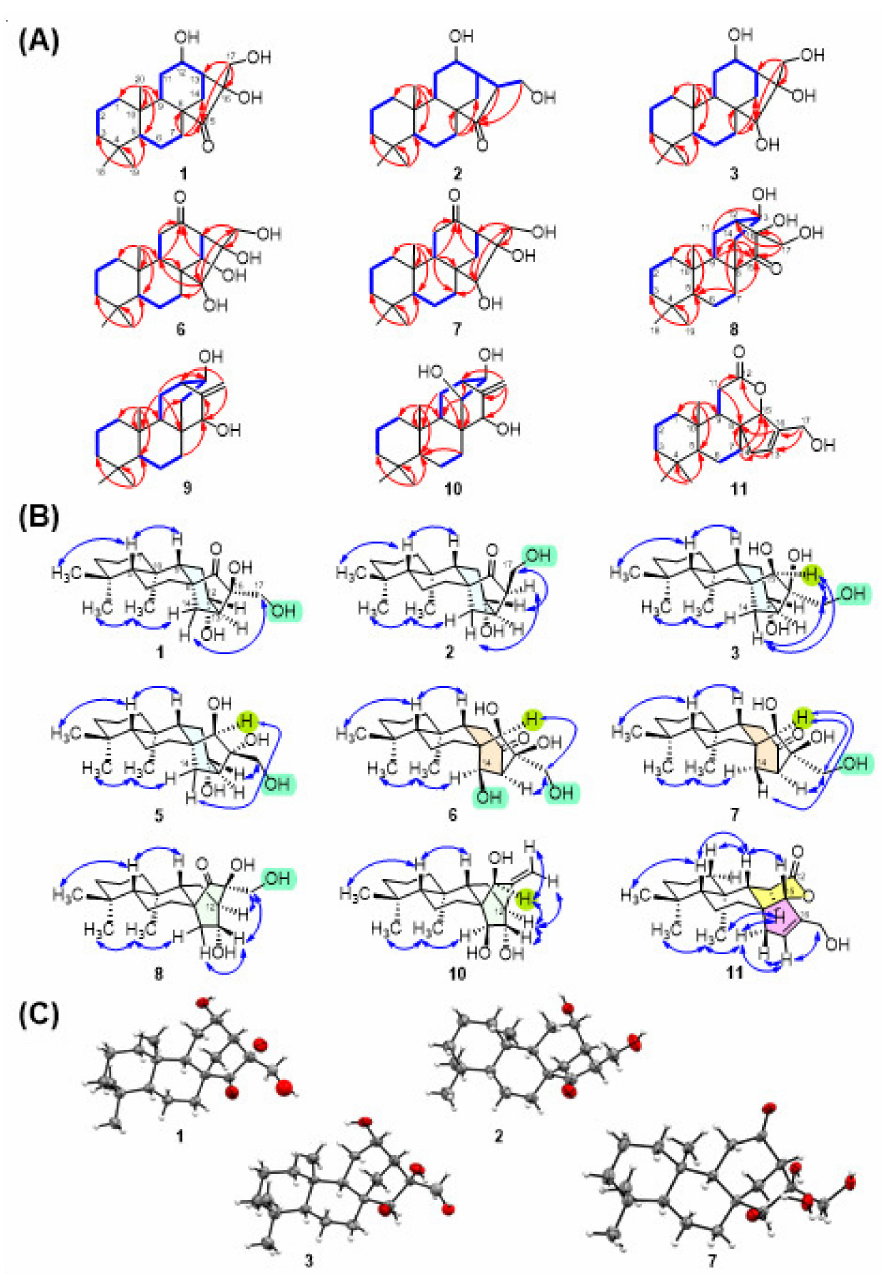
Figure 2. 2D-NMR correlations and X-ray ORTEP drawings of the isolates. ( A ) 1 H- 1 H COSY (–) and key HMBC ( → ) correlations of 1 – 3 and 6 – 11 . ( B ) Main NOESY correlations of 1 – 3 , 5 – 8 and 10 – 11 . ( C ) X-ray ORTEP drawings of 1 – 3 and 7